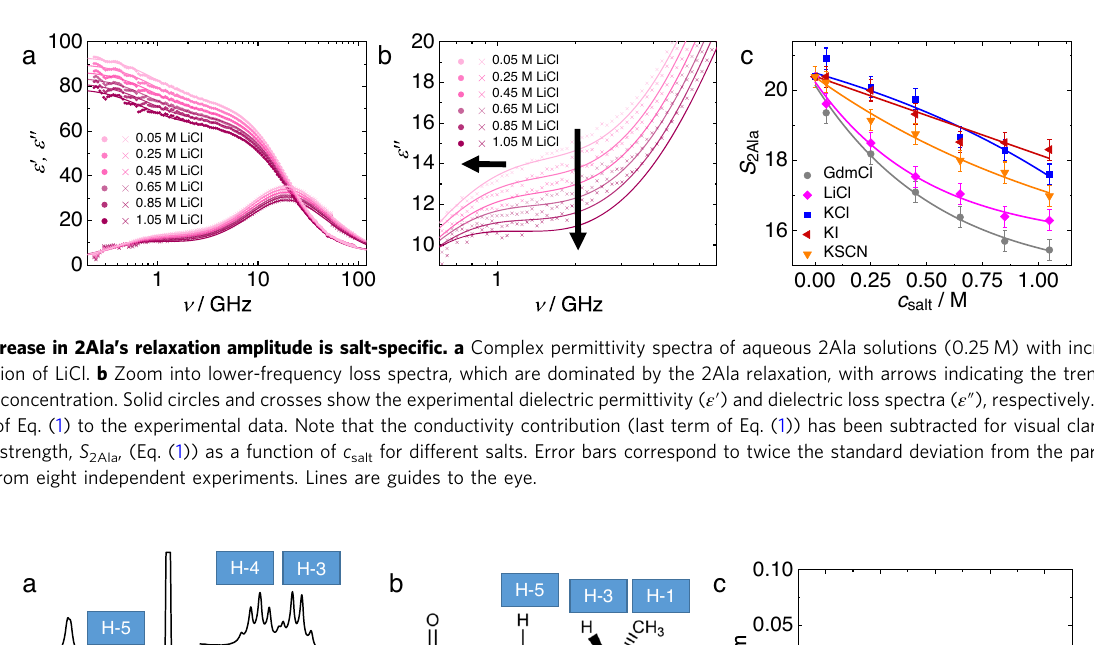
(cid:1) (cid:1) (cid:3) ¼ 50mM (cid:2) δ c 2Ala ¼ 0. Error bars show the typical experimental reproducibility rel